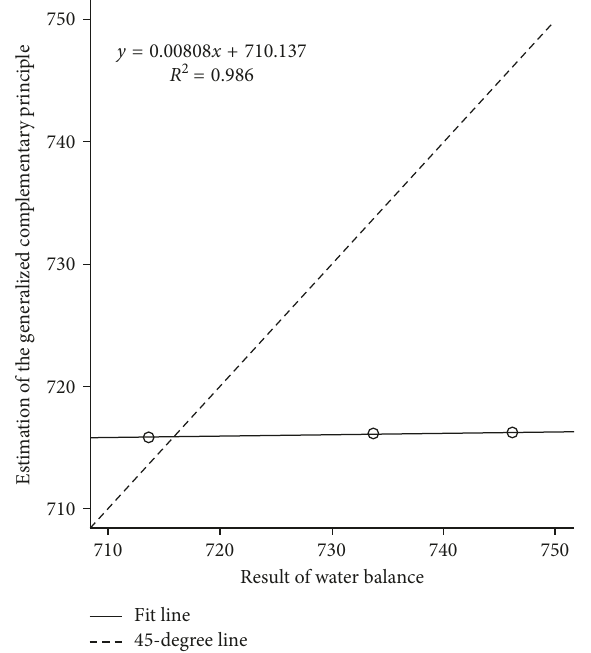
Figure 3: Regression plot of water balance and generalized complementary simulation using the R -square.